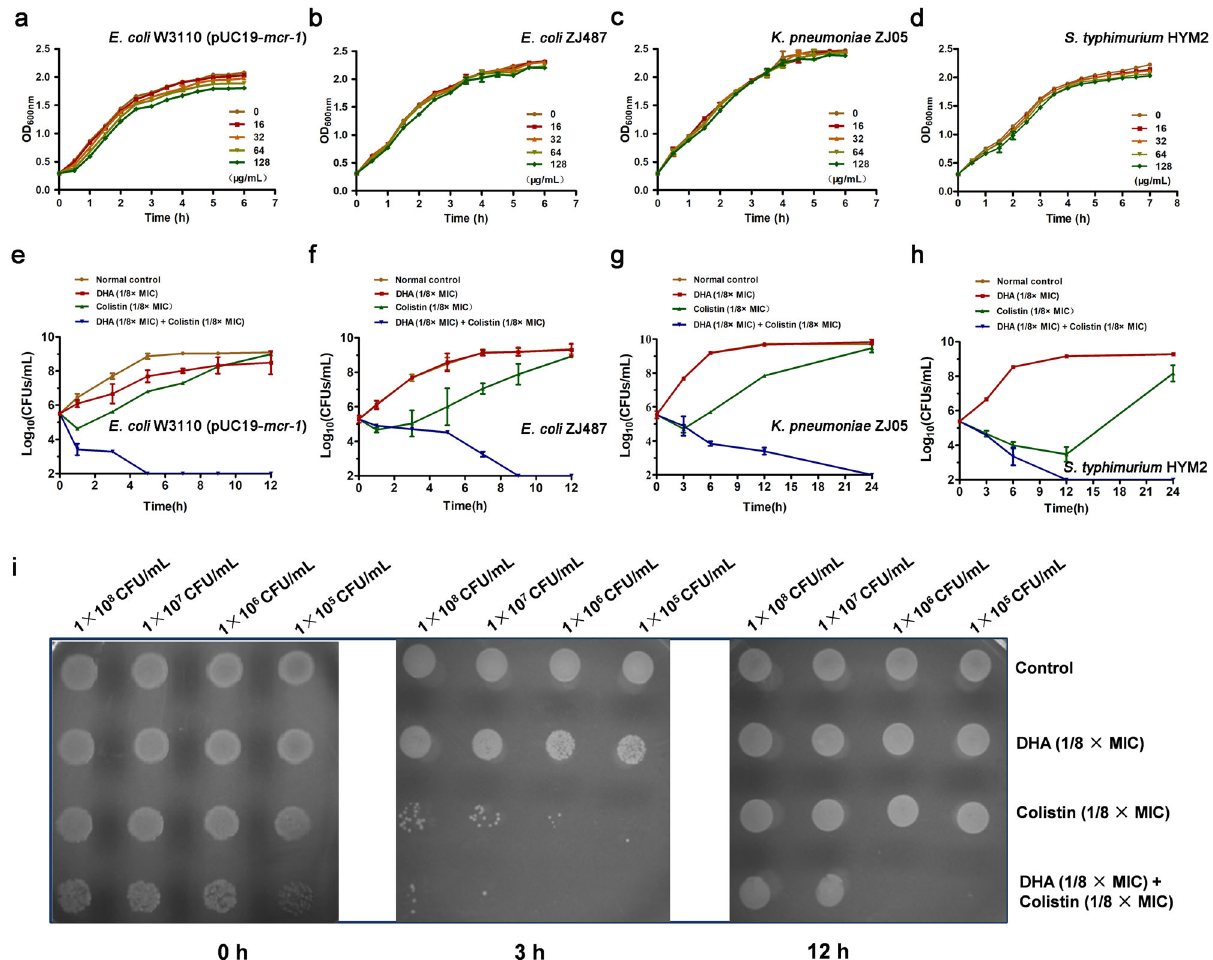
Fig. 2 DHA enhances the bactericidal ef fi cacy of colistin without affecting bacterial growth. a – d Growth curves for E. coli W3110 (pUC19- mcr-1 ) ( a ), E. coli ZJ487 ( b ), K. pneumoniae ZJ05 ( c ) and S. typhimurium HYM2 ( d ) cultured in the presence of various concentrations of DHA (0, 16 – 128 µ g/mL). e – h Time-killing curves for DHA, colistin, combination and control treatment against E. coli W3110 (pUC19- mcr-1 ) ( e ), E. coli ZJ487 ( f ), K. pneumoniae ZJ05 ( g ) and S. typhimurium HYM2 ( h ). Values represent the averages of three independent experiments. i Three microliters of E. coli W3110 (pUC19- mcr-1 ) bacteria with different treatments (concentrations from 1 × 10 8 CFU/mL to 1 × 10 5 CFU/mL) were dropped on LB agar plates at 0, 3 and 12 h and cultured at 37 °C overnight. All the growth curves and bactericidal test were determined in triplicate, and representative data are